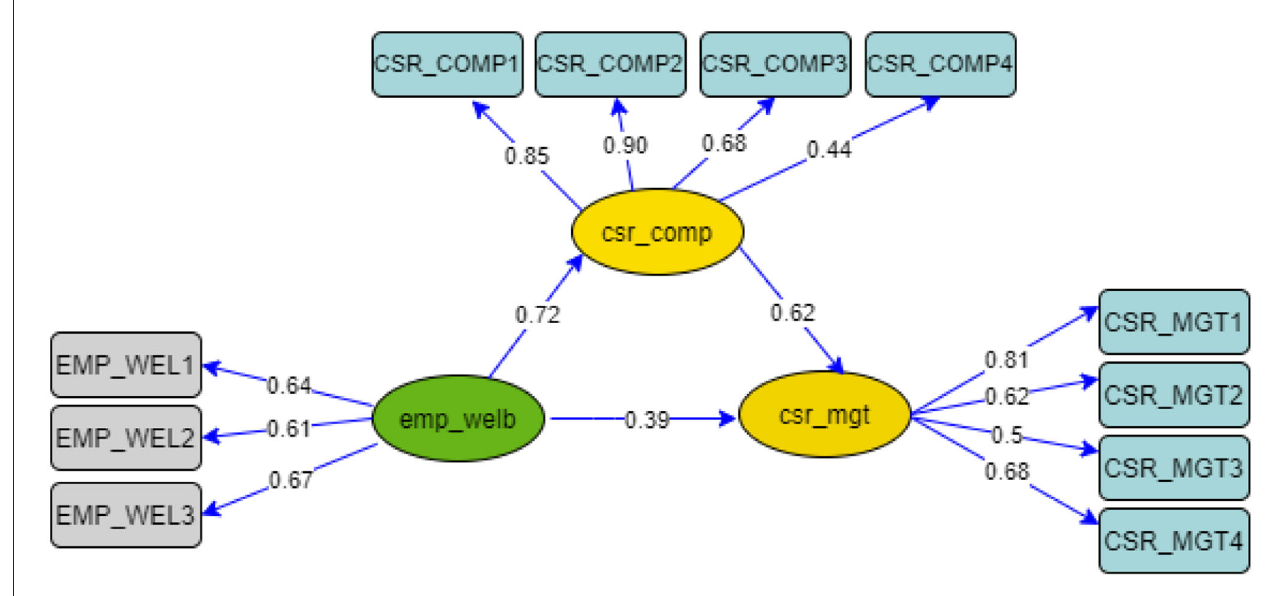
FIGURE5 Mediation analysis.